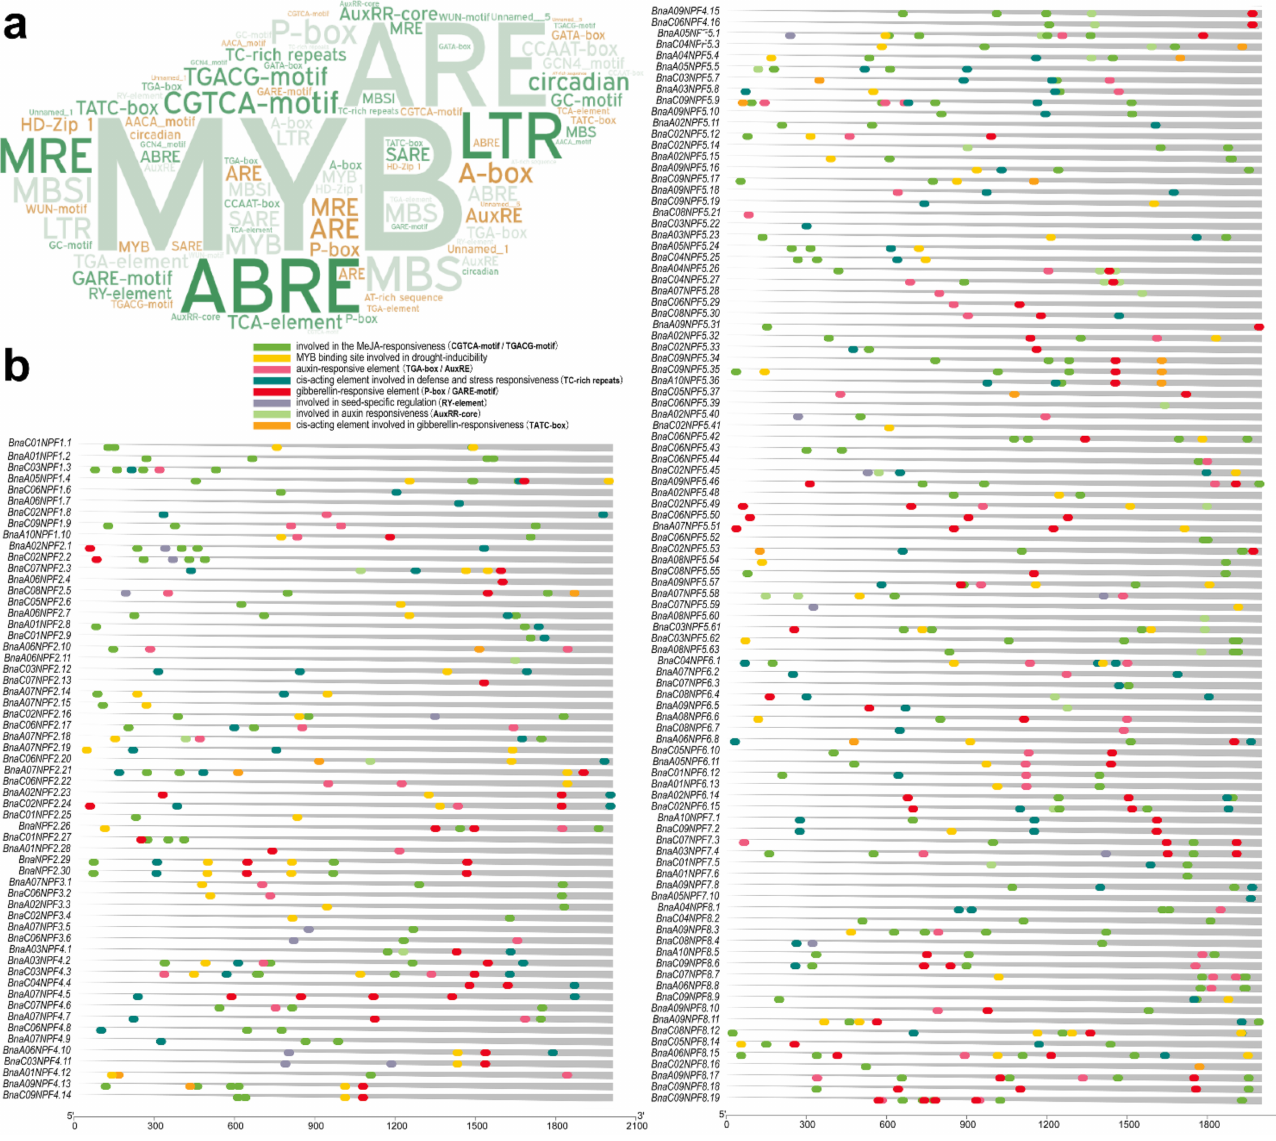
Figure 2. Identification of the CREs of the BnaNPF genes. ( a ) Over-presentation of the CREs in the promoters of the 157 BnaNPF genes. The bigger the font size, the more frequent the CRE appears in BnaNPF genes. ( b ) Genomic distribution and relative abundance of the 8 kinds of CREs involved in the molecular response of plants to phytohormone, abiotic stress responsiveness and seed-specific regulation in the BnaNPF gene promoters. Different kinds of CREs are indicated with different